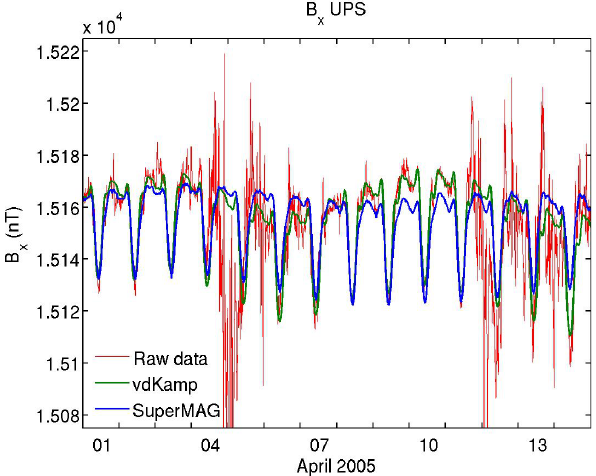
Fig. 13. B x field at Uppsala from 1 to 15 April 2005 (red), the base- line derived as described in this paper (green), and the SuperMAG baseline (blue).